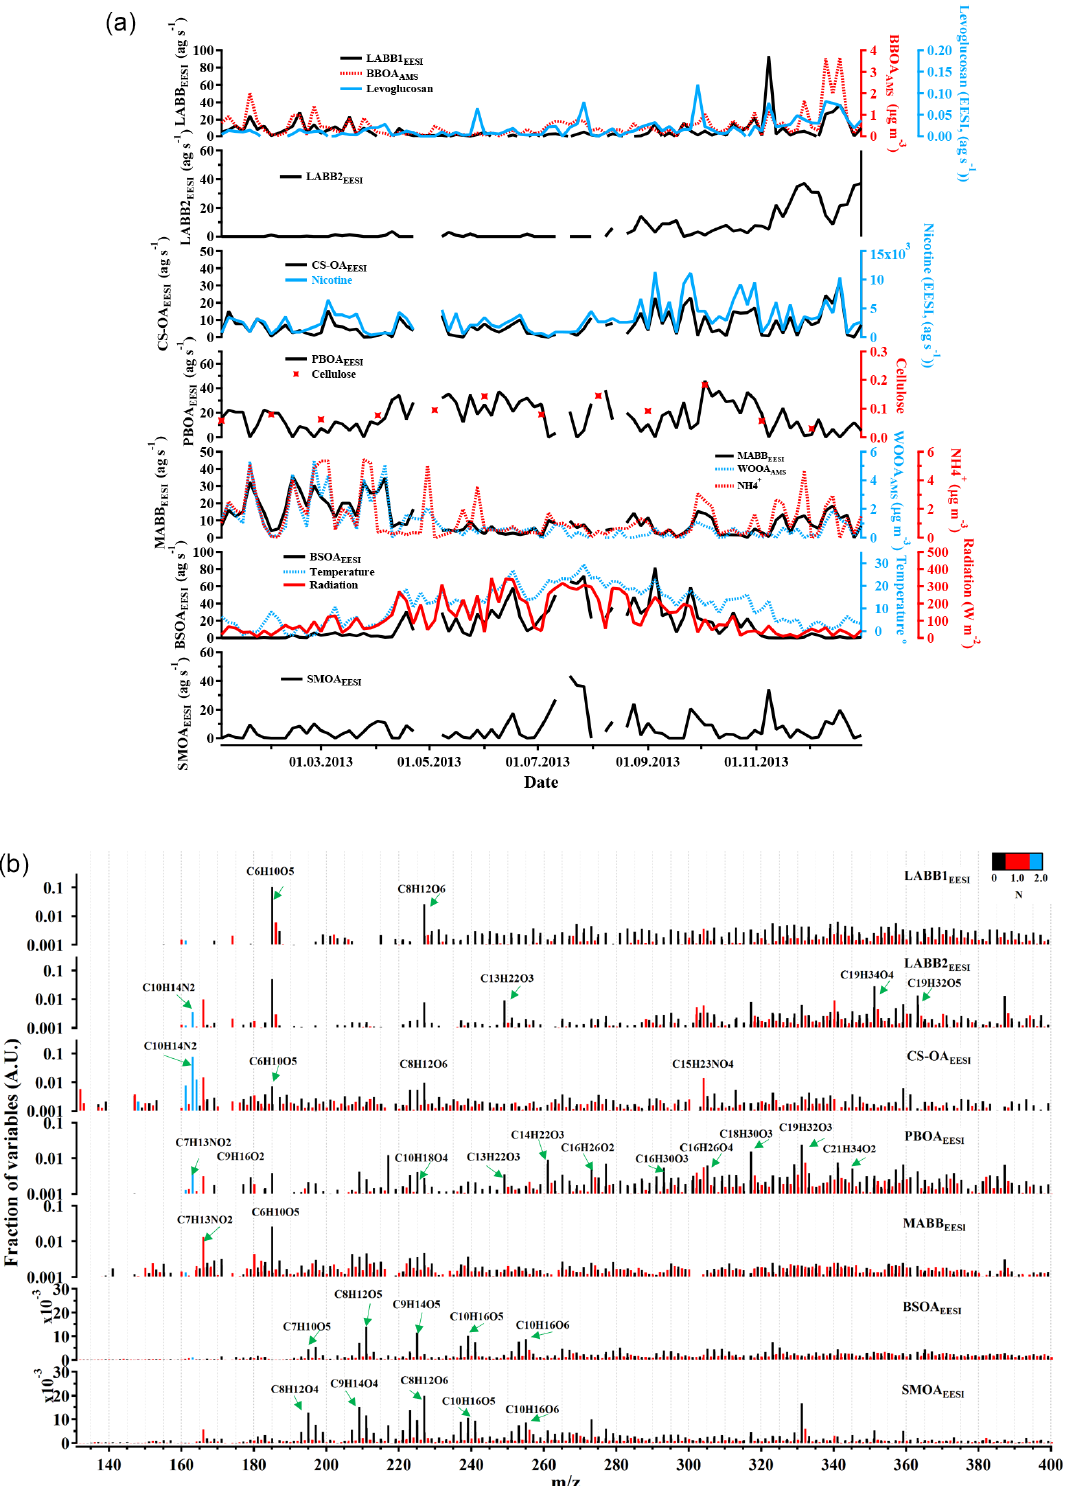
Figure 2. (a) Time series of the EESI-TOF PMF analysis for the seven-factor solution, along with ancillary data. (b) Corresponding factor profiles. For all y axes, EESI-TOF data are shown as mass flux (ags − 1 ), AMS data are shown in µgm − 3 , and other units are